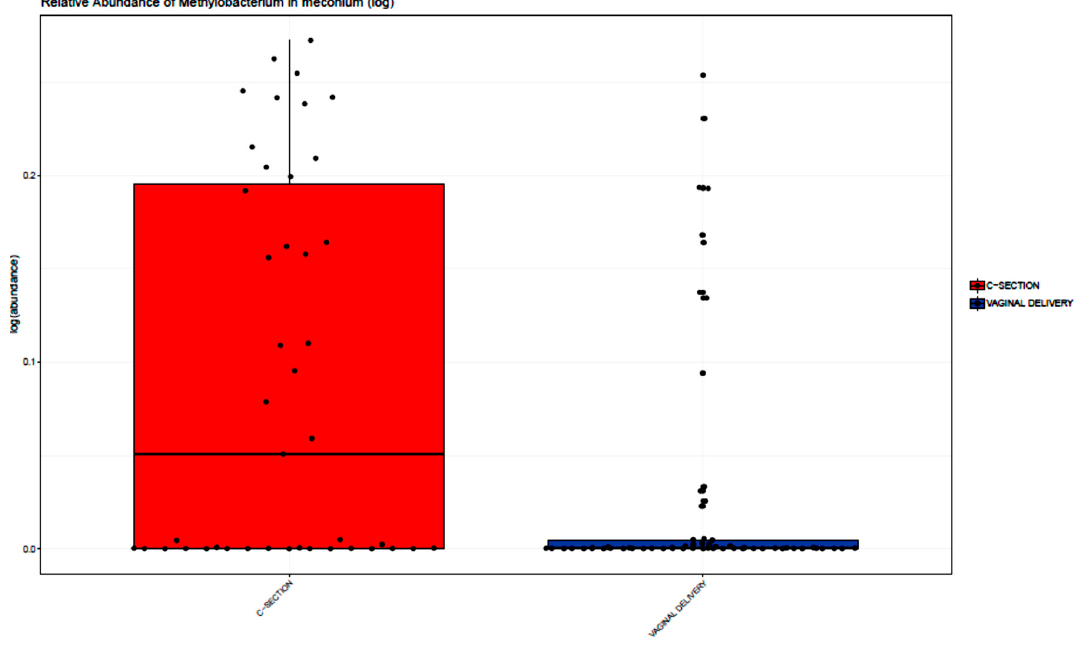
Figure 3. Relative abundance of Methylobacterium in meconium samples stratified by delivery mode. For each colored box: Horizontal bar = median, lower bar = first quartile (25th percentile), and upper bar = third quartile (75th percentile). Methylobacterium was higher in CS (27%) compared with VD (8%) adjusted p = 0.001. Microorganisms 2019 , 7 , x FOR PEER REVIEW